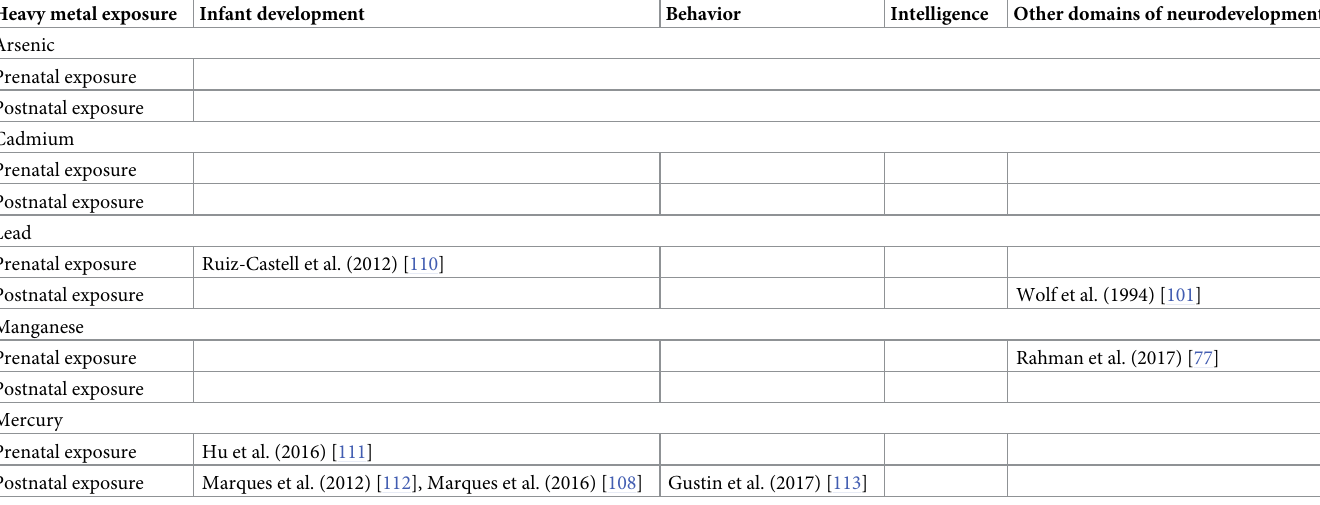
Table 3. Studies that found positive associations between heavy metal exposures and various domains of neurodevelopment.